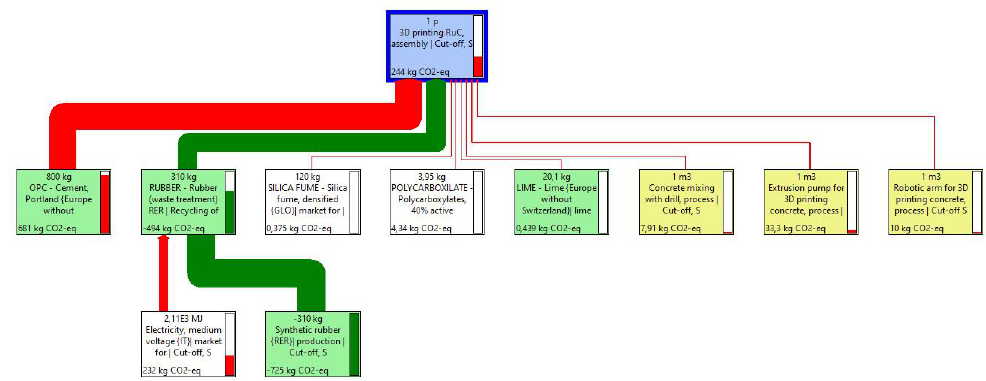
Figure A3. SimaPro GWP network for p-RuC mix processing.